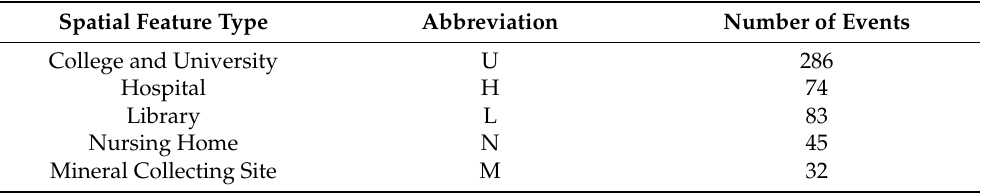
Table 2. Description of event numbers of spatial feature